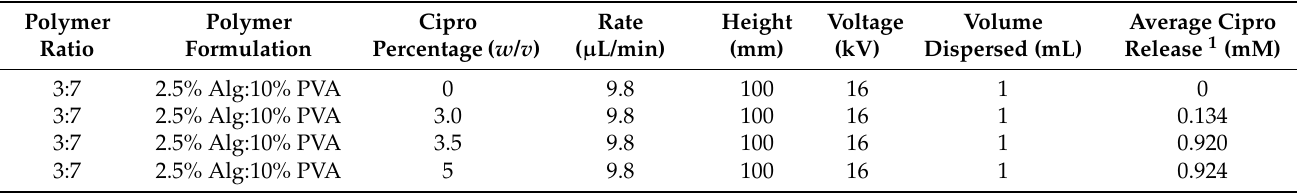
Table 1. Compilation of Alg-PVA Release Study